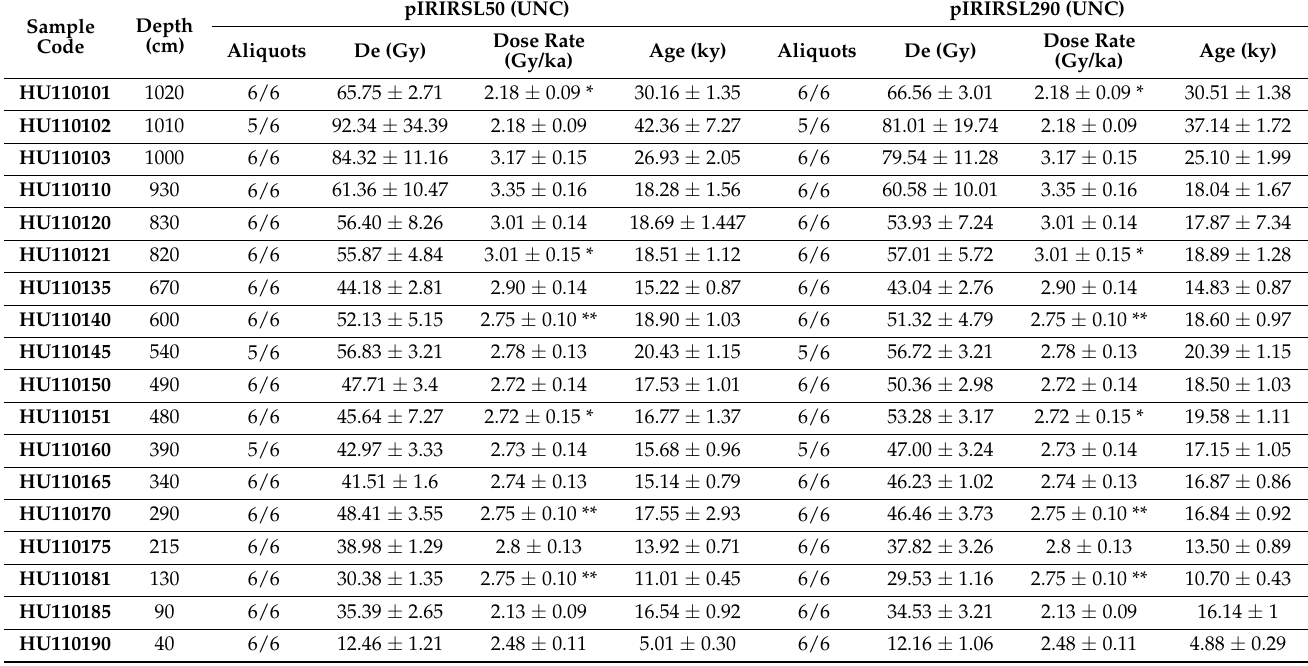
Table 3. Equivalent doses, dose rates and feldspar luminescence